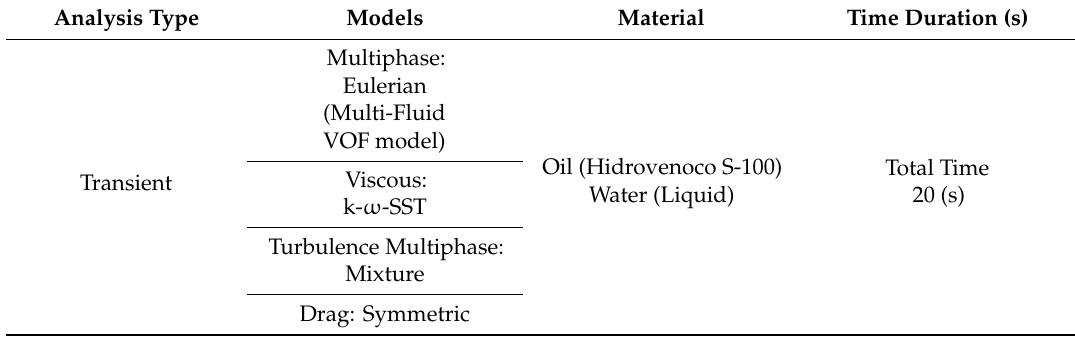
Table 3. Fluent input deck.